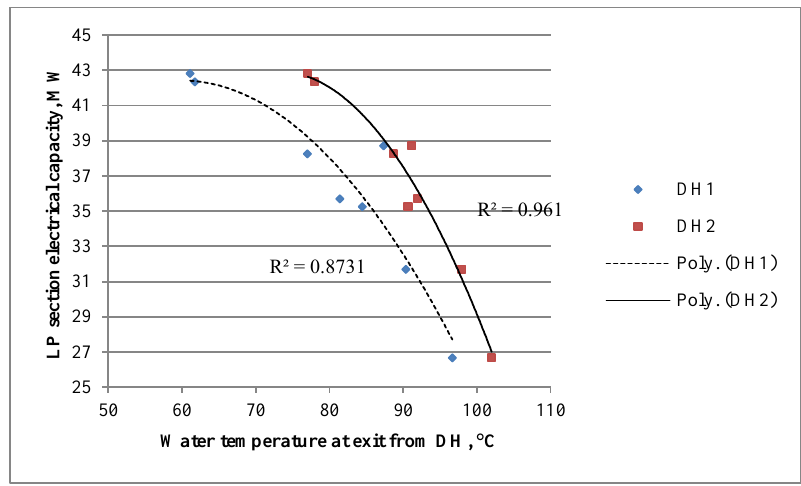
Fig. 2. Relation between LP section electrical capacity and water temperature at the exit from DH.